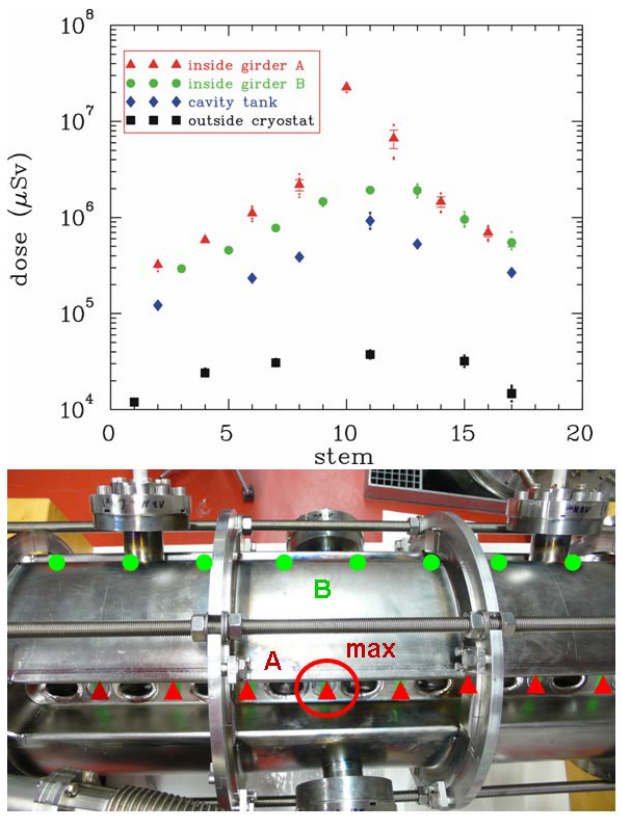
FIG. 35. (Color) Measured sensitivity of the resonance fre- quency against external pressure variations.